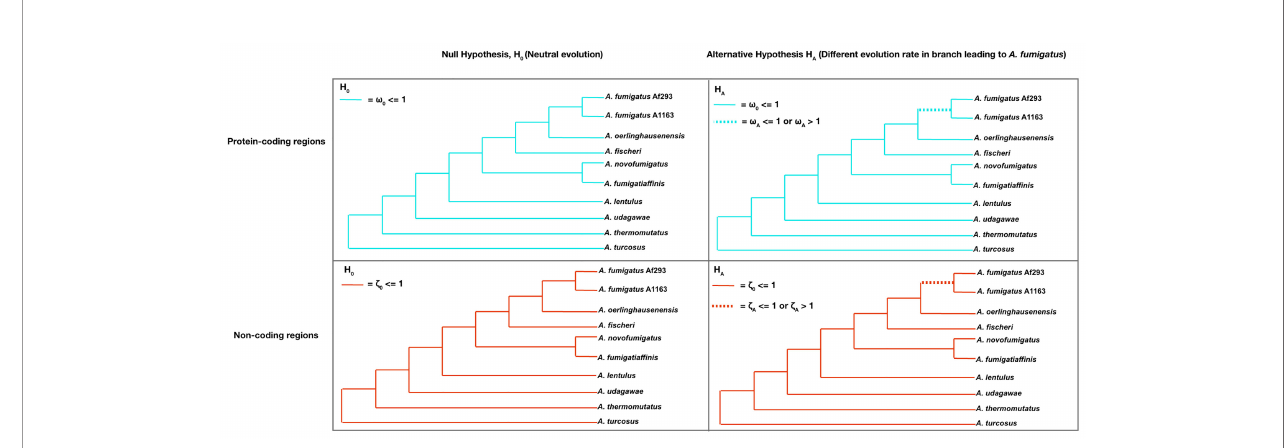
FIGURE 2 | Examining whether the non-coding and protein-coding regions of 732 genes have different evolutionary rates in the major pathogen A. fumigatus . The top two panels present the null and alternative hypotheses for evolutionary rate difference in the protein-coding regions of A. fumigatus genes relative to the other species. The null hypothesis (H 0 , upper left) constrains all w (dN/dS) values across all branches to be less than or equal to 1, the neutral evolutionary rate. The alternativehypothesis(H A , upper right) allows the branch leadingto A. fumigatus (dashed branch) to have an w value lower than,equalto, orgreater than 1 (indicative of evolutionaryrate difference) compared to the background branches. The bottom two panelspresent the nulland alternativehypotheses for evolutionary rate difference in the non-coding regionsof A. fumigatus genes relative to other species. Similarly,the nullhypothesis (H 0 , bottomleft) constrainsall z (dNC/dS) values across allbranches to less than orequalto 1. The alternative hypothesis(H A , bottom right) allows for the branch leadingto A. fumigatus (dashed branch) to have a z value lower than,equalto, or greater than 1 (evolutionaryrate difference) compared to the background branches. For each protein-coding andnon-codingregion,a likelihood ratiotest was usedto determine which hypothesis best fi ts the